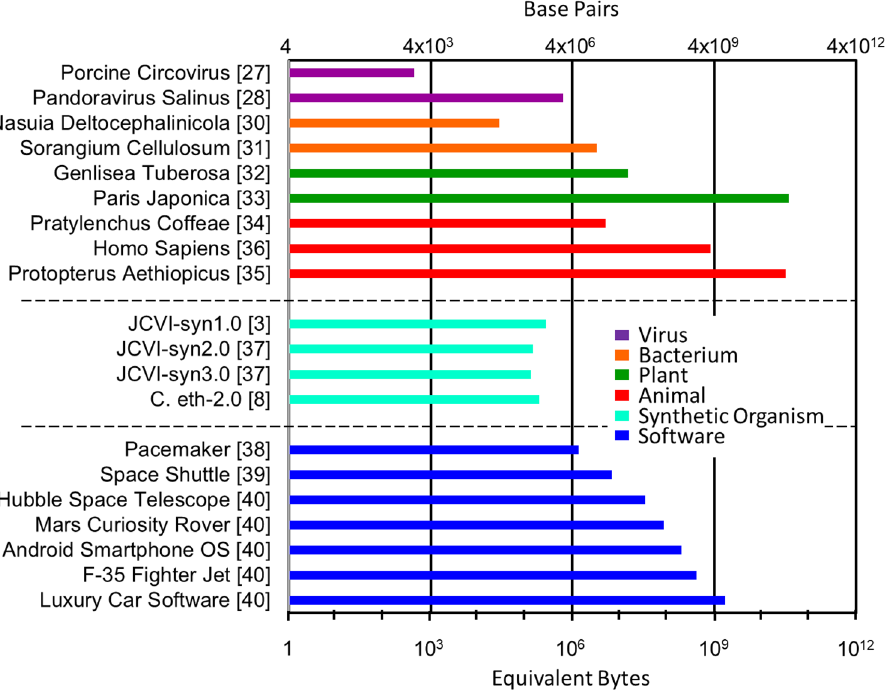
Figure 4. Complexity of selected natural organisms (in terms of base pairs) and software benchmarks (in terms of equivalent bytes) 3,8,27,28,30–40